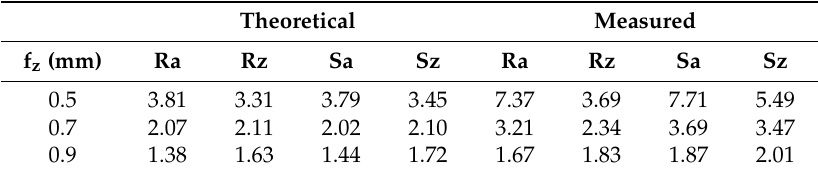
Table 5. The degree of increase in roughness values when changing the number of inserts. Theoretical Measured